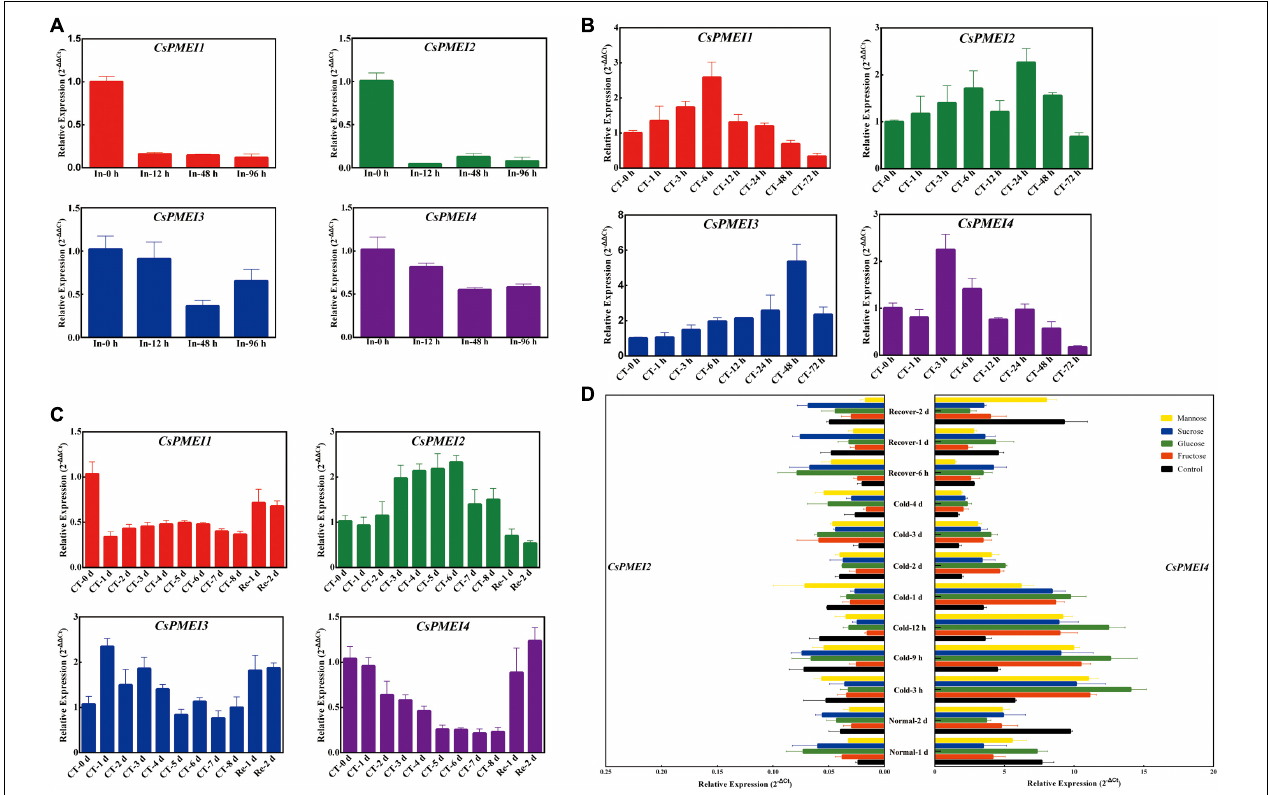
FIGURE 3 | Temporal-spatial expression patterns of CsPMEIs in response to biotic, cold and various sguar treatments. (A) Expression profiles of CsPMEIs under C. fructicola infection condition. Samples at 0 h were used as control, and the final results were calculated with 2 - (cid:49) (cid:49) Ct method. ‘In’ represents infection treatment. Data are shown as the means ± SE ( n = 3). (B) Expression profiles of CsPMEIs at one bud and one leaf stage of tea plant under cold condition. Samples at 0 h were used as control, and the final results were calculated with 2 - (cid:49) (cid:49) Ct method. ‘CT’ represents cold treatment. Data are shown as the means ± SE ( n = 3). (C) Expression profiles of CsPMEIs at one bud and three leaves stage of tea plant under cold condition. Samples at 0 h were used as control, and the final results were calculated with 2 - (cid:49) (cid:49) Ct method. ‘CT’ represents cold treatment. Data are shown as the means ± SE ( n = 3). (D) Expression analysis of CsPMEIs in tea plant leaves under different sugar and temperature conditions. All results were calculated by using the 2 - (cid:49) Ct method. Data are shown as the means ± SE ( n = 3).